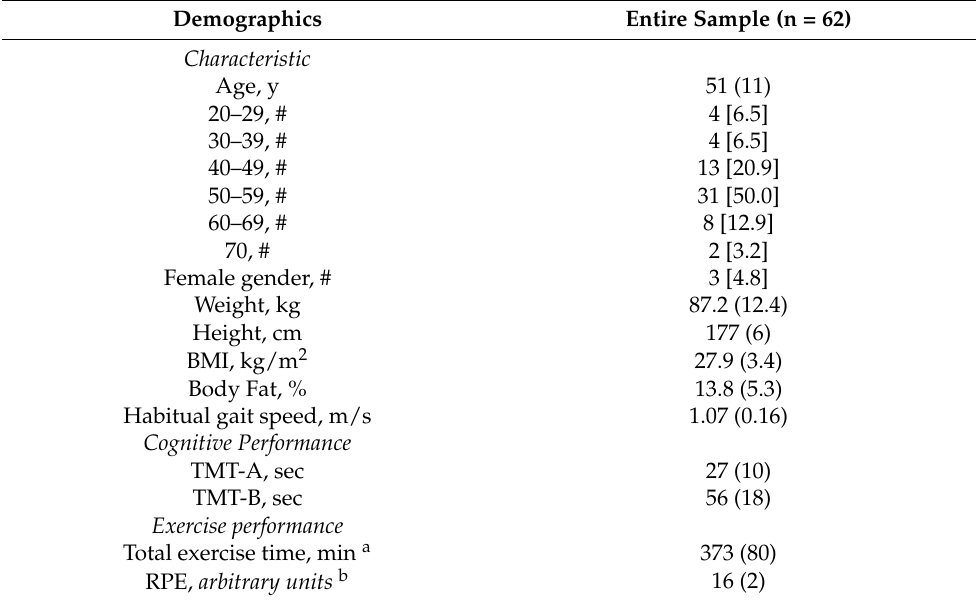
Table 1. Participant demographics, pre-exercise cognitive function, and exercise performance. Demographics Entire Sample (n = 62)